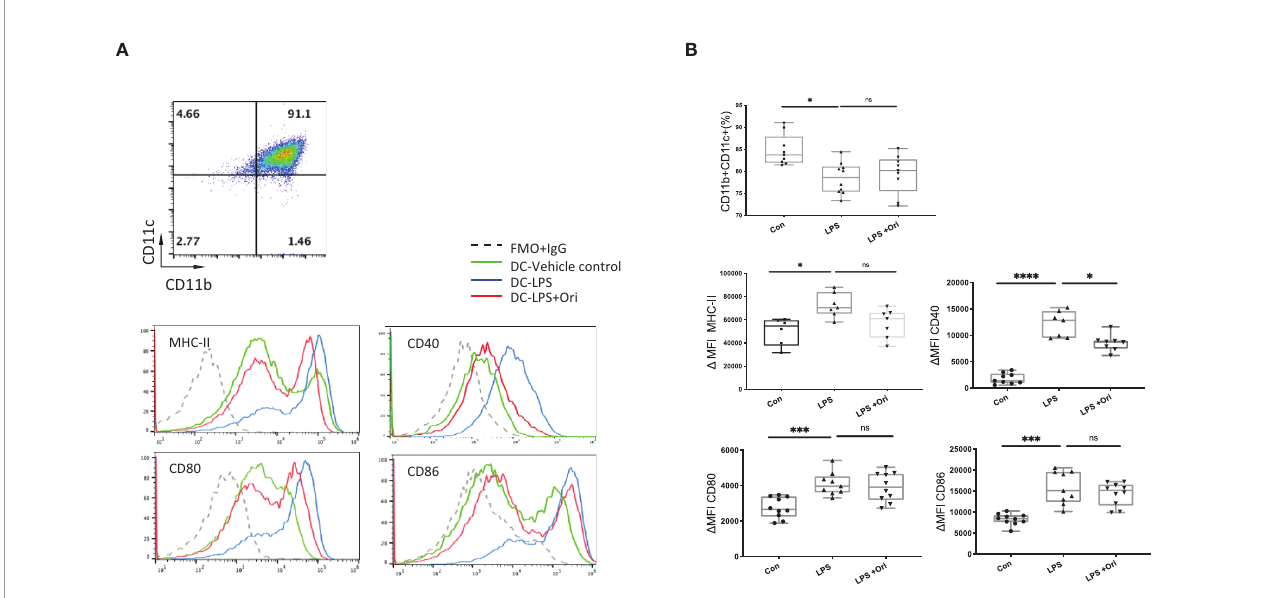
FIGURE 5 | Ori treatment affected the percentage and phenotypes of BMDCs in vitro . (A) Representative FCM analysis of BMDCs (CD11b + CD11c + ) and the histogram graphs of the MHC-II, CD40, CD80, and CD86 on the gated CD11b + CD11c + population of different groups are shown. (B) The percentages of the CD11b + CD11c + population and the median fl uorescence intensity ( D MFI) of MHC-II, CD40, CD80, and CD86 of BMDCs in each group were calculated. D MFI was subtracted from the MFI value of the Isotype control of each antibody of the fl uorescence intensity. Values are shown as the mean ± SD; * p < 0.05, *** p < 0.001, **** p < 0.0001, ns, not signi fi